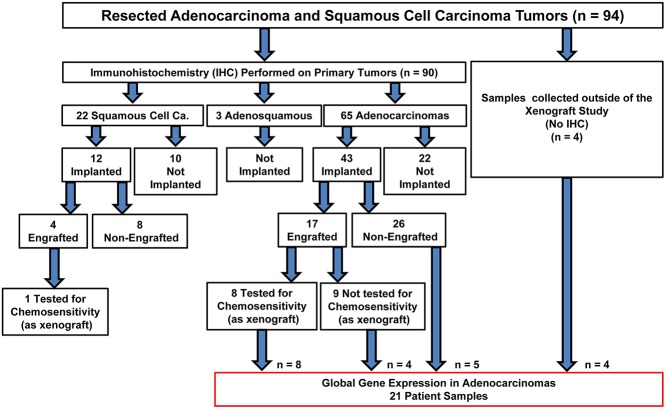
Consort diagram describing patient tumors used in this study, including those evaluated for global mRNA abundance, the expression of molecular markers through immunohistochemistry (IHC), and chemosensitivity as patient-derived xenografts.